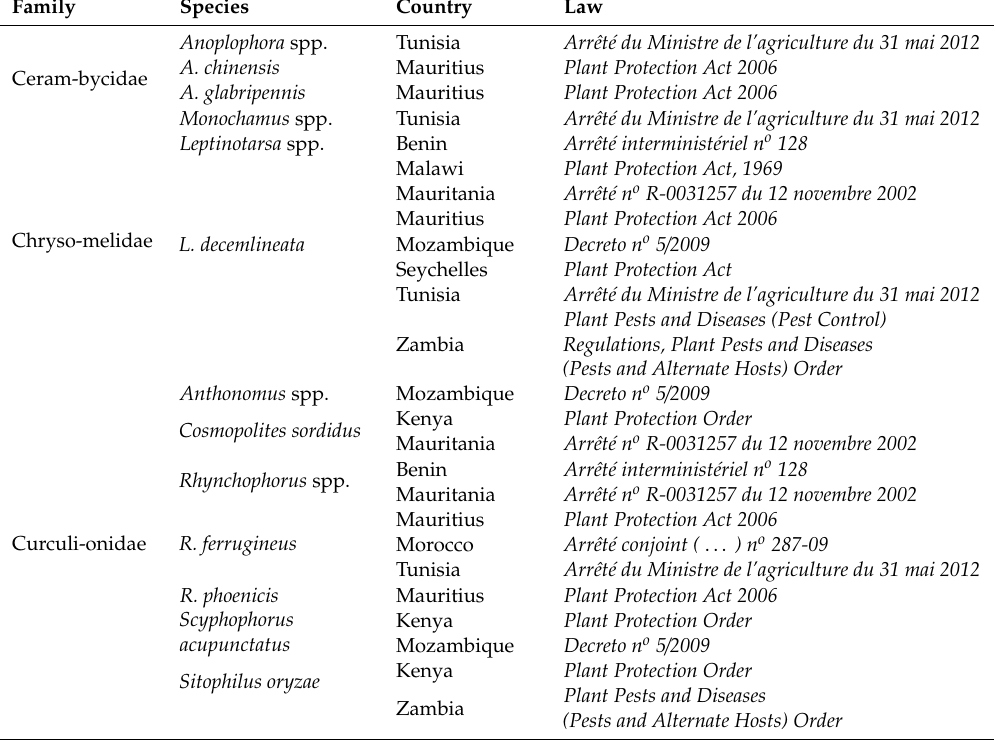
Table 9. Pest insect legislation pertaining edible insect species (as presented in [11]): beetles (Coleoptera); Eswatini also refers to “woodborer beetles”, but without any species information, a term that, in fact, can be used to several